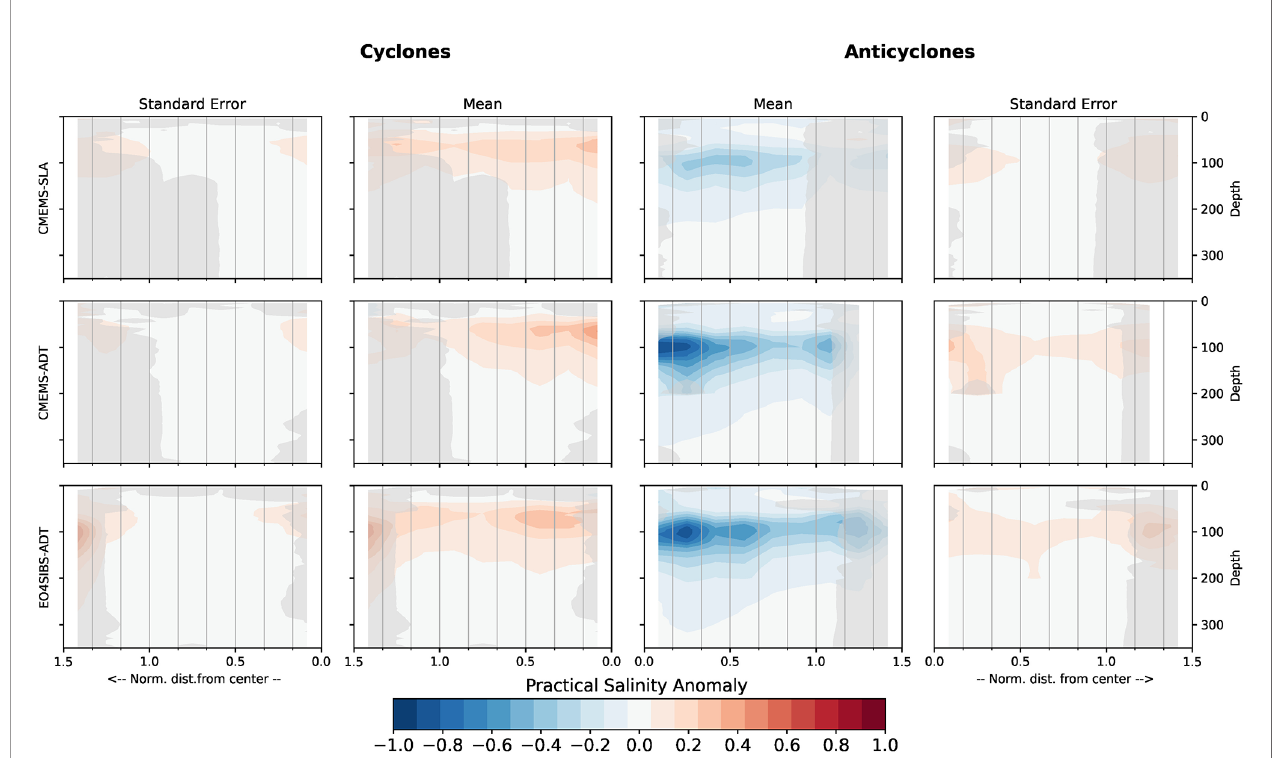
FIGURE 10 | Characterization of subsurface salinity anomalies associated with (left panels) cyclones and (right panels) anticyclones. (Central panels) mean anomaly, (external panels) standard error on the mean. The shaded area covers regions of the eddy-centric coordinate systems where the mean anomalies cannot be considered as statistically different from zero with a con fi dence level of